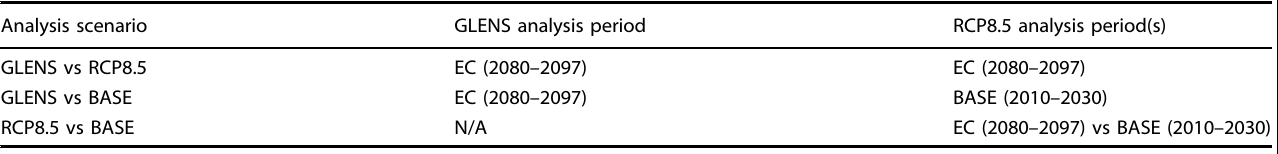
Table 1. Simulation analysis periods for Geoengineering (GLENS) and RCP8.5